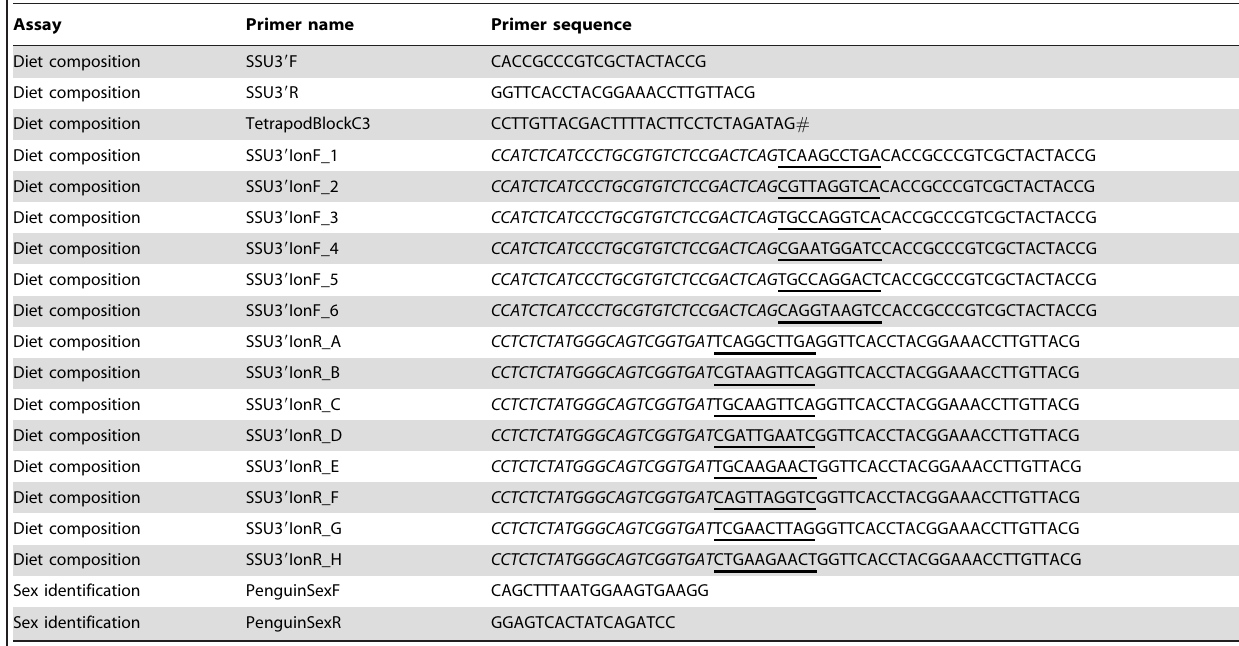
Table 2. Oligonucleotides used in this